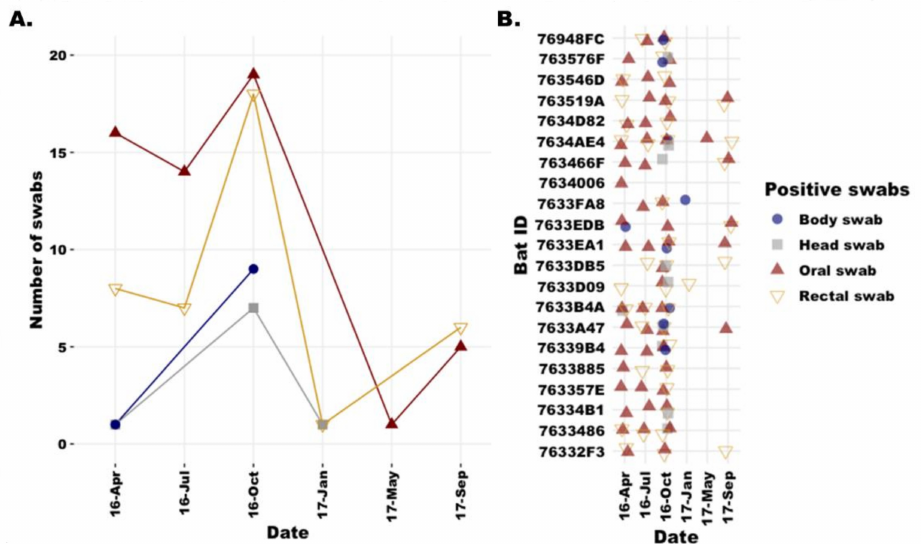
Figure 4. Frequency of detection among swab types and bats within the captive colony. ( A ) The number of swabs from which DbPV was detected in each swab type is graphed by sample collection date. The total number of head (grey square), body (navy circle), oral (red, solid triangle), and rectal (gold, hollow triangle) swab samples that contained reads mapping to DbPV are plotted by collection date. ( B ) Specific swab and bat ID information for each swab from which reads mapped to DbPV are plotted with individual bats on the y-axis and date on the x-axis. Color/shape corresponds to swab